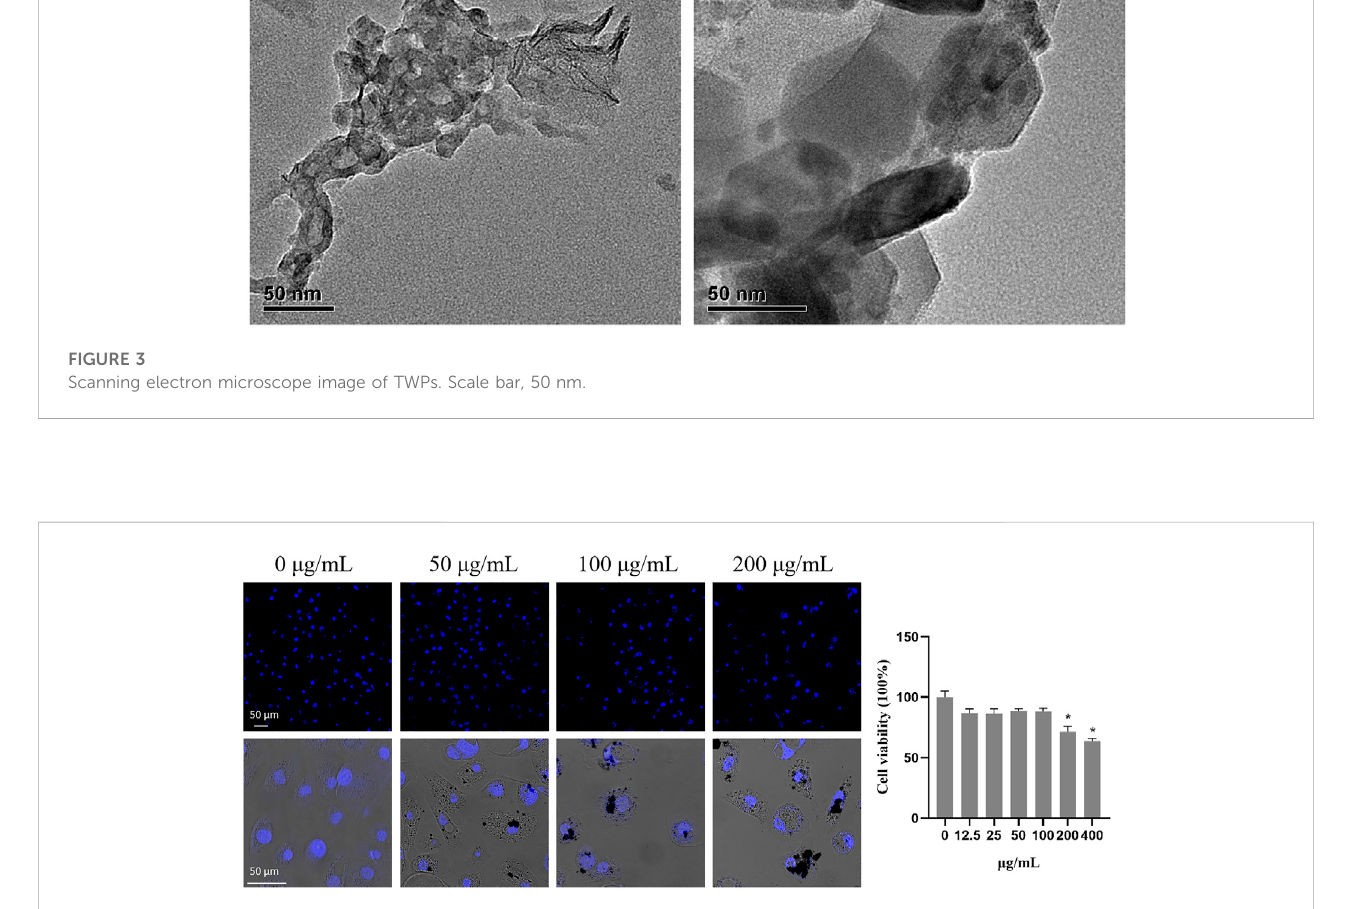
FIGURE 4 Cytotoxicity of TWPs on HBECs. Nuclei were stained by DAPI to determine the number of cells; scale bar, 50 μ m. Data are presented as the cell viability normalized to the control. Values represent the mean ± SD of three independent experiments.